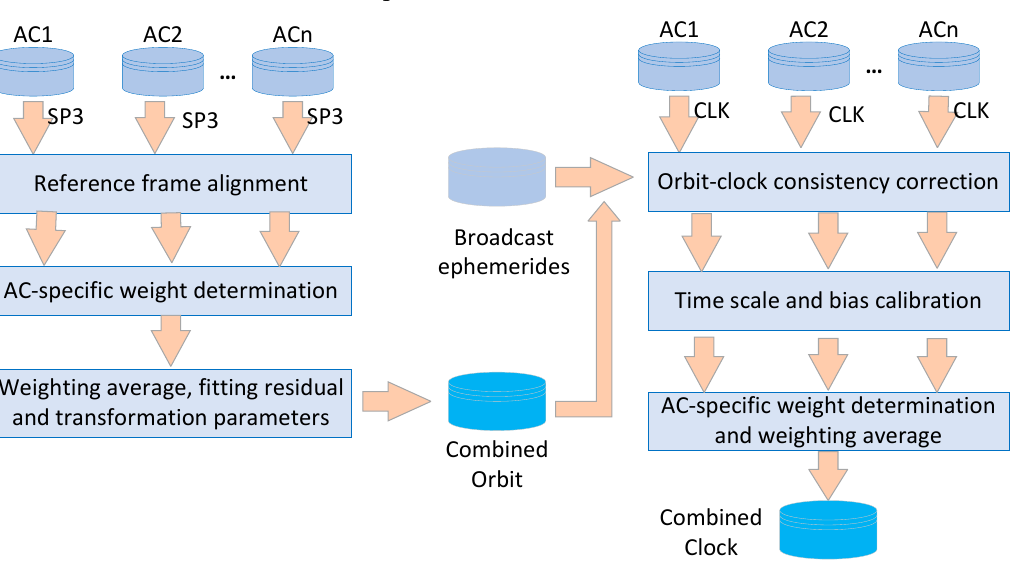
Figure 2. The flowchart of iGMAS orbit and clock combination.